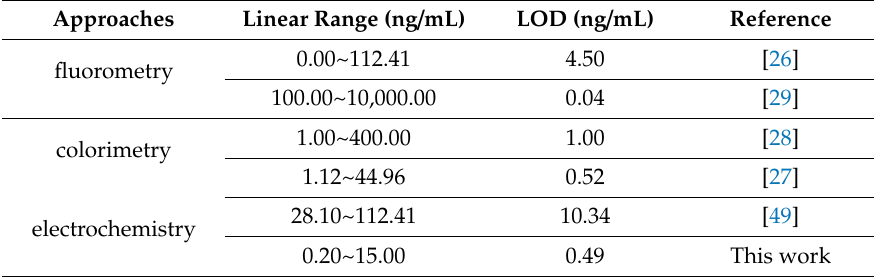
Table 1. Comparison of di ff erent aptamer-based approaches for Cd 2 + determination.